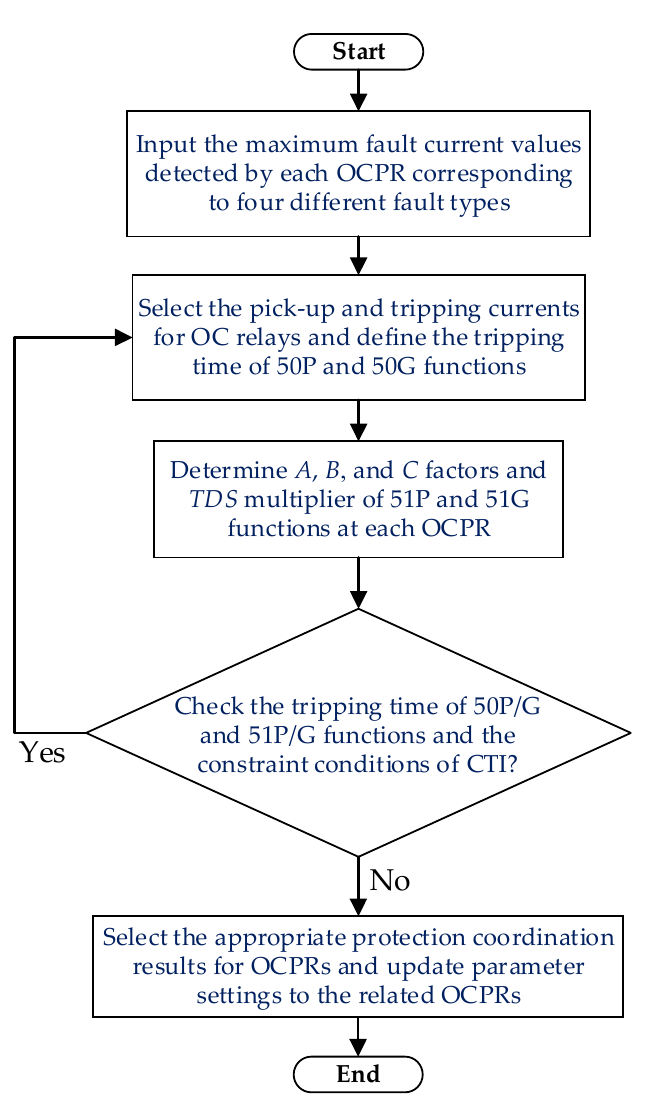
Figure 5. A general flow-chart of the proposed ASPC approach for OCRs in a DG-based distribution network.